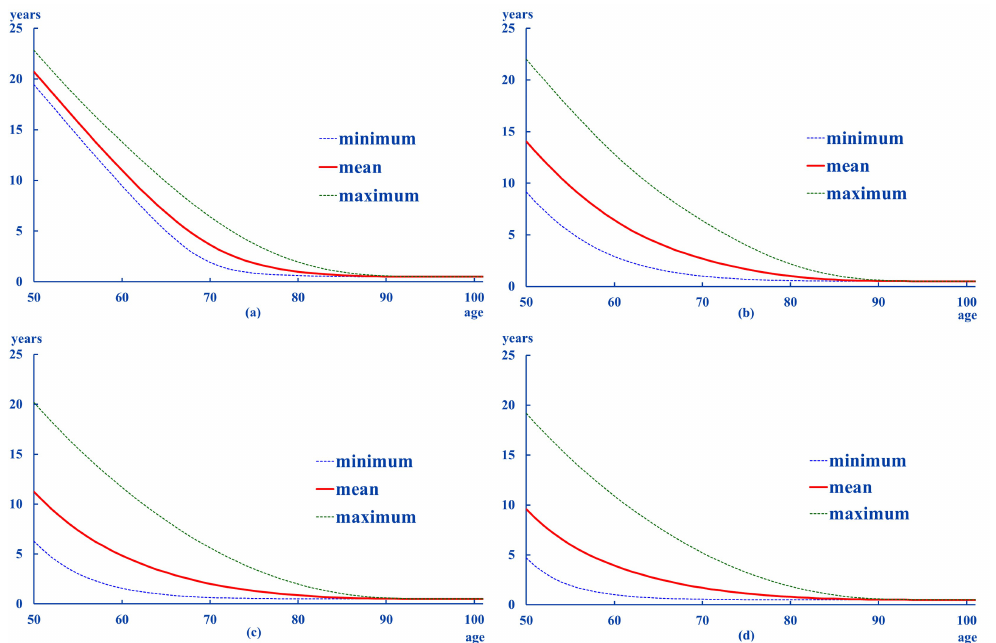
Figure 3. e x : women. ( a ): Degree 0, ( b ): Degree I, ( c ): Degree II, ( d ): Degree III. The values for each age are higher for women than for men. Tables 1 and 2 summarize the pattern of life expectancy by both sex and